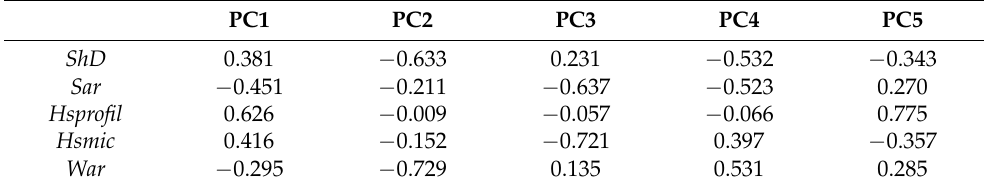
Table 15. Principal components